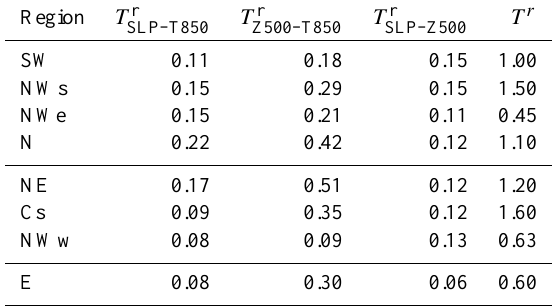
Table 10. Regional EHD trends (days/decade). The first three columns show the trends obtained from the attribution exercise con- sidering the different classifications. Last column shows the ob- served trends derived from regional series.